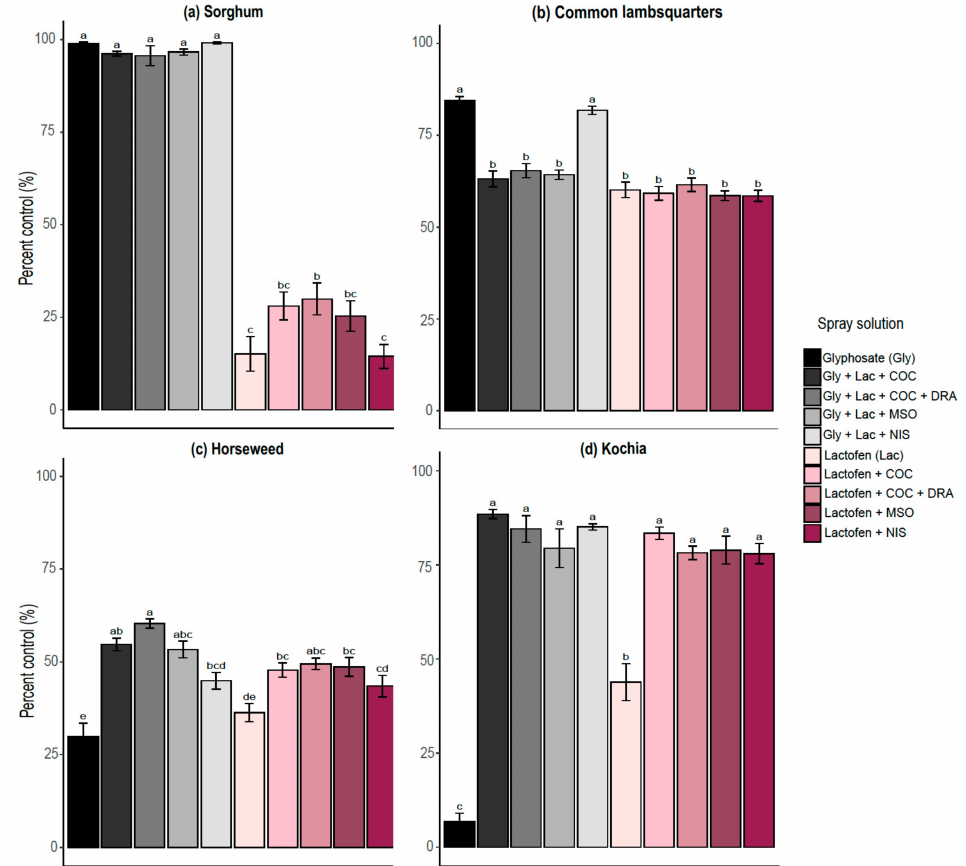
Figure 3. Percent of ( a ) sorghum, ( b ) common lambsquarters, ( c ) horseweed, and ( d ) kochia control based on dry biomass at 28 DAT treated with different herbicide tank-mixtures as affected by the addition of different adjuvants and averaged over nozzle types evaluated from a greenhouse study conducted in 2017. Bars with same letter do not differ using Tukey post-hoc test at α =